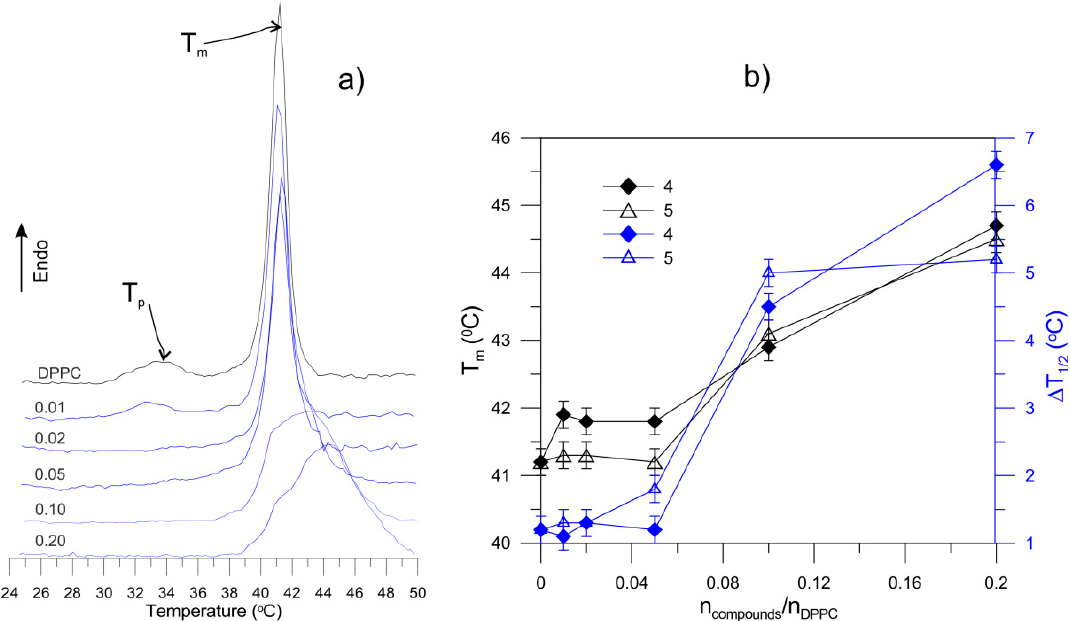
Figure 1. ( a ) Original DSC curves of DPPC and DPPC mixed liposomes with an increasing concentration of acylglycerol 5 ; ( b ) The influence of different concentration of acylglycerols of myristic acid containing stigmasterol on the main phase transition temperature T m (black curves) and half-width of the main peak Δ T 1/2 of DPPC mixed liposomes (blue curves).